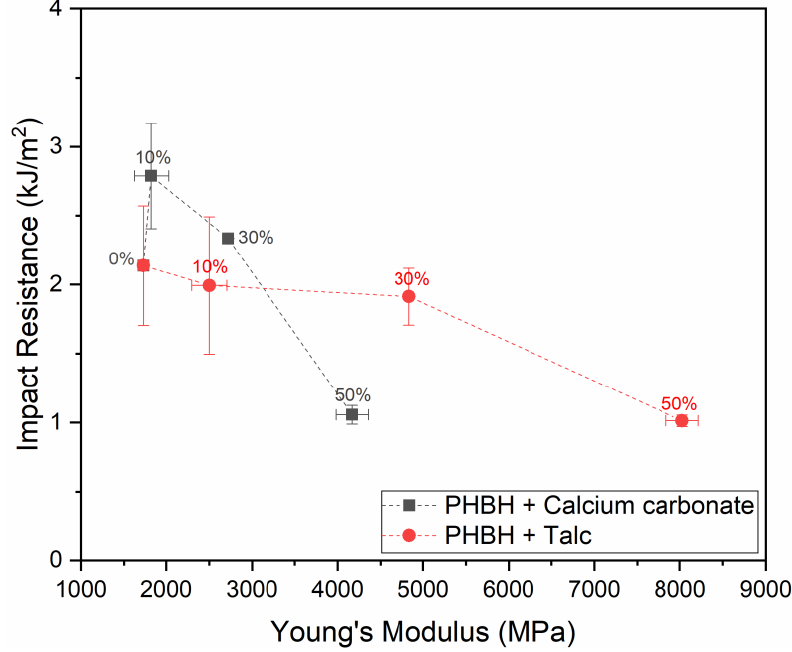
Figure 4. Relation between the Young’s modulus and notched impact resistance particulate PHBH composites.